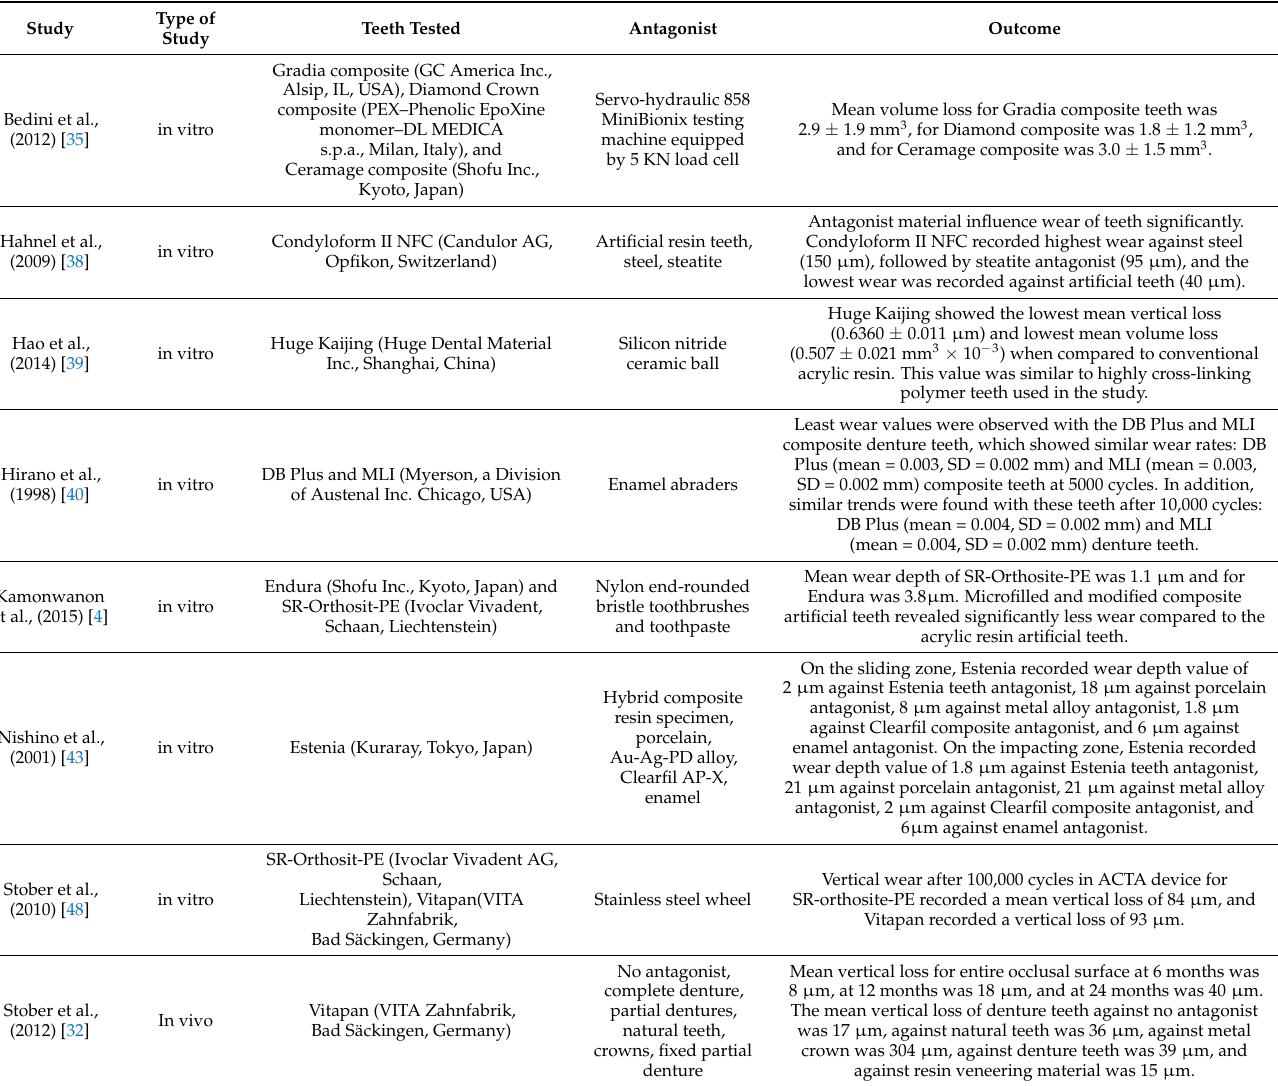
Table 5. Main findings of the selected studies on denture teeth wear